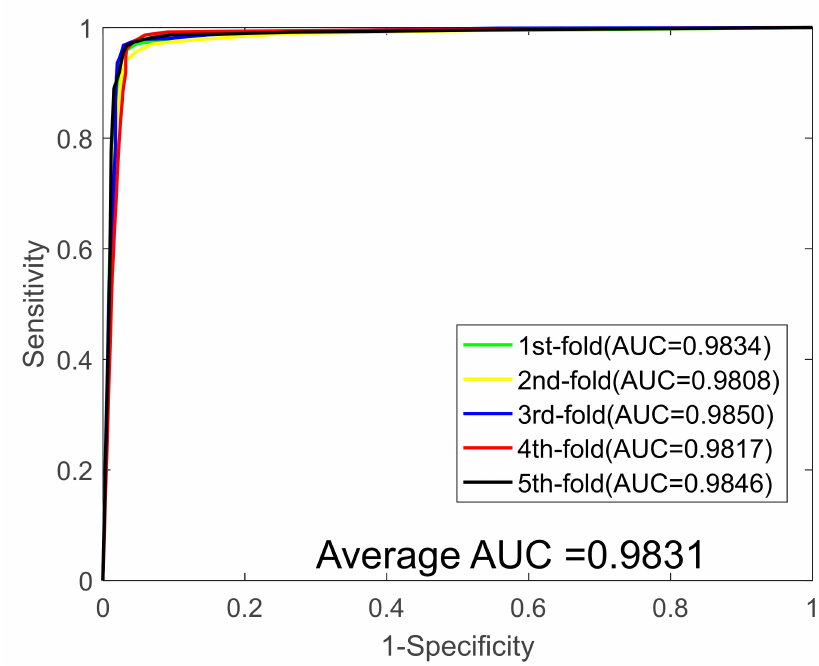
Figure 2. ROC curves generated by the proposed model on the Human dataset.